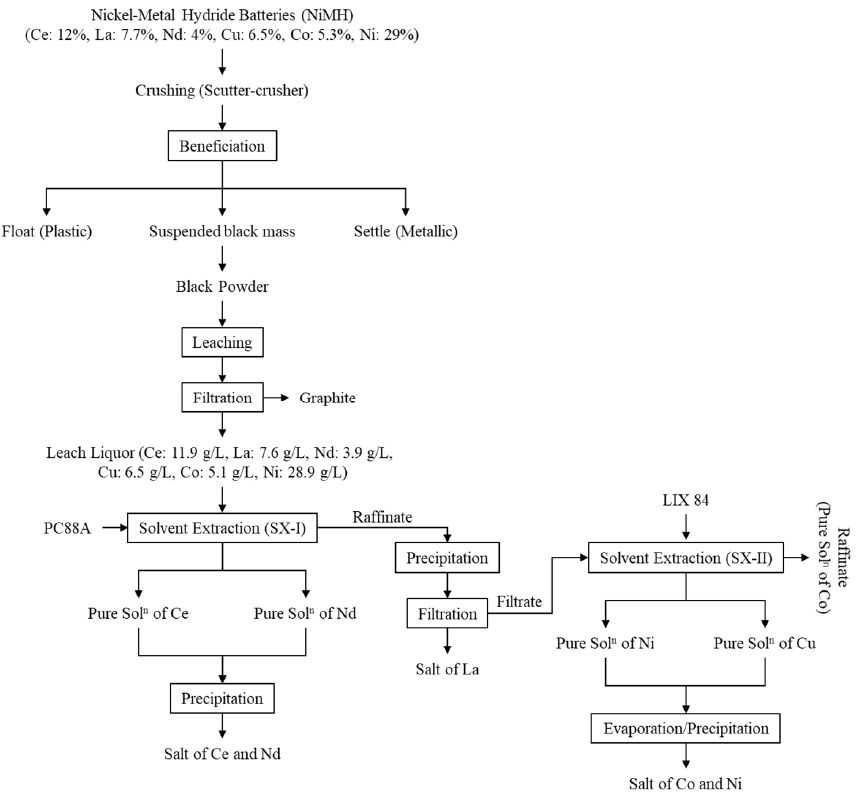
Figure 12. Developed process flowsheet for extraction of rare metals, Cu, Ni and Co from discarded NiMH batteries of electric vehicles.